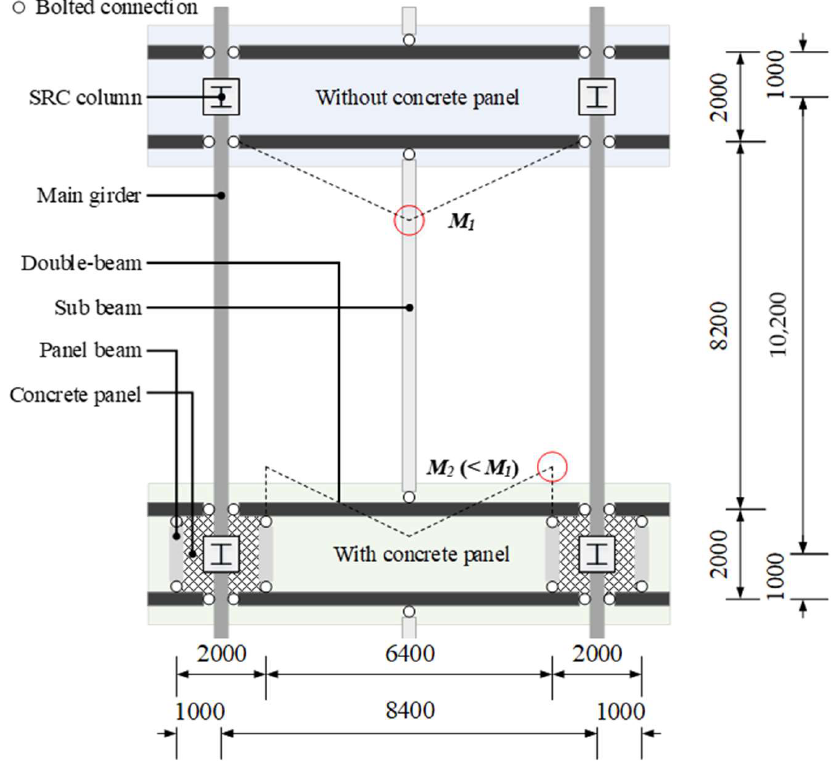
Figure 1. Structural plan of steel double-beam floor systems and comparison of bending moment of double-beam according to the absence of concrete panel (unit in mm).